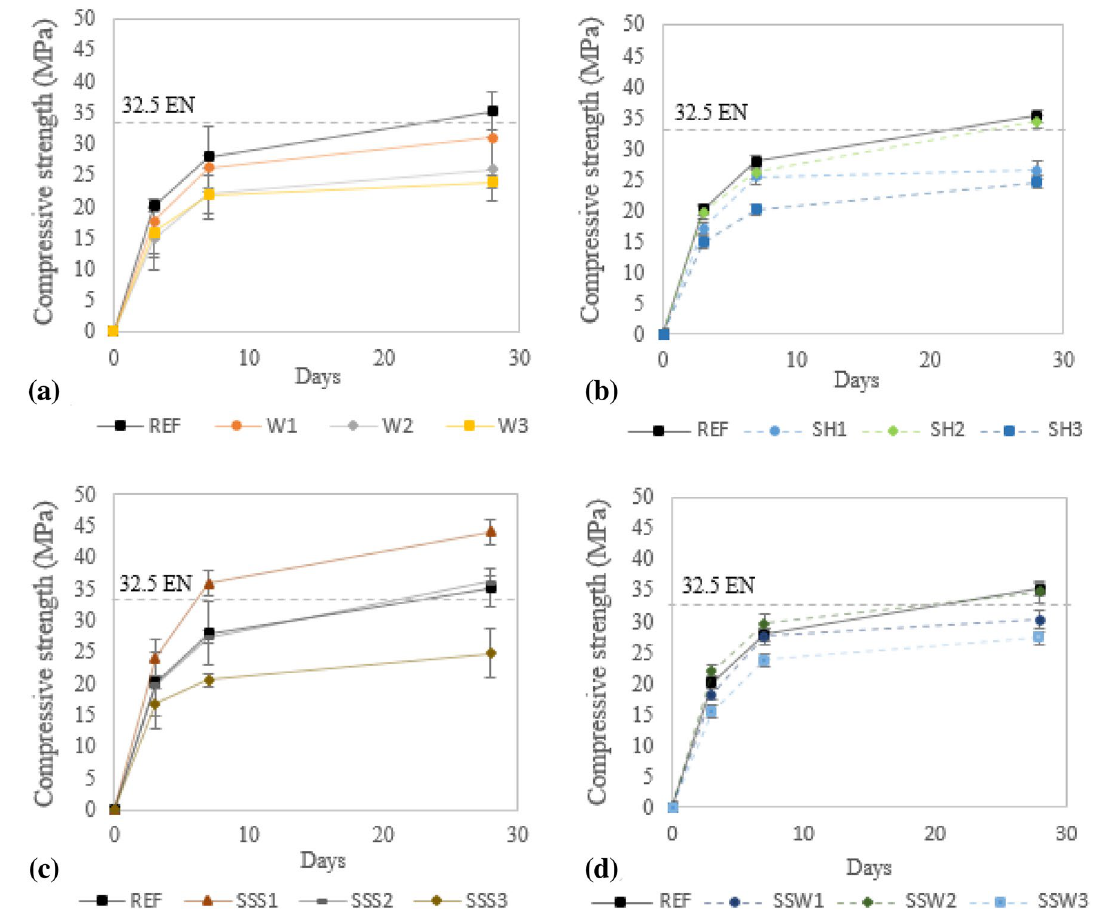
Fig. 6 Compressive strength development over time of a group W, b group SH, c group SSS, and d group